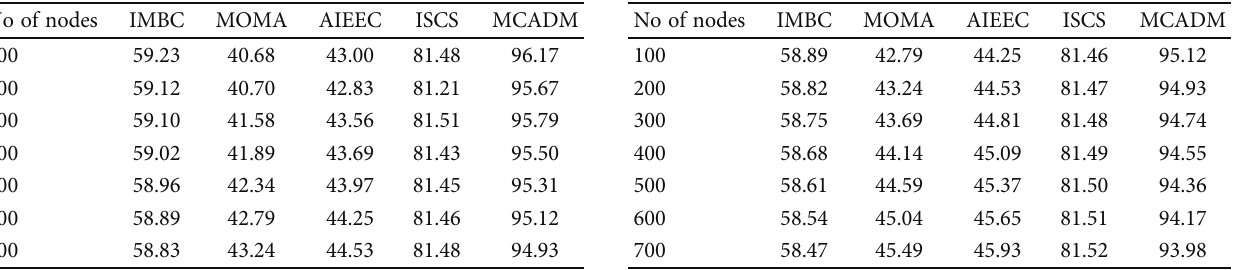
Table 3: Management of network topology.